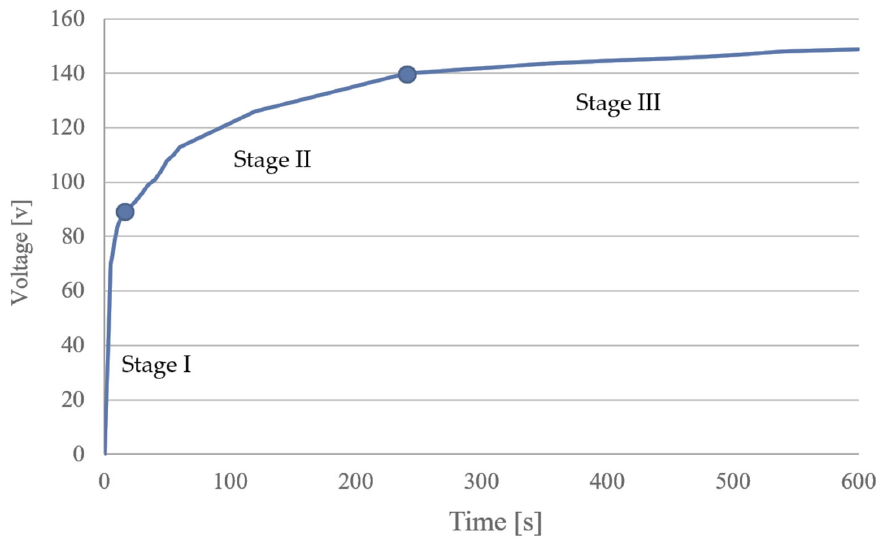
Figure 1. Voltage–time plot during plasma electrolytic oxidation